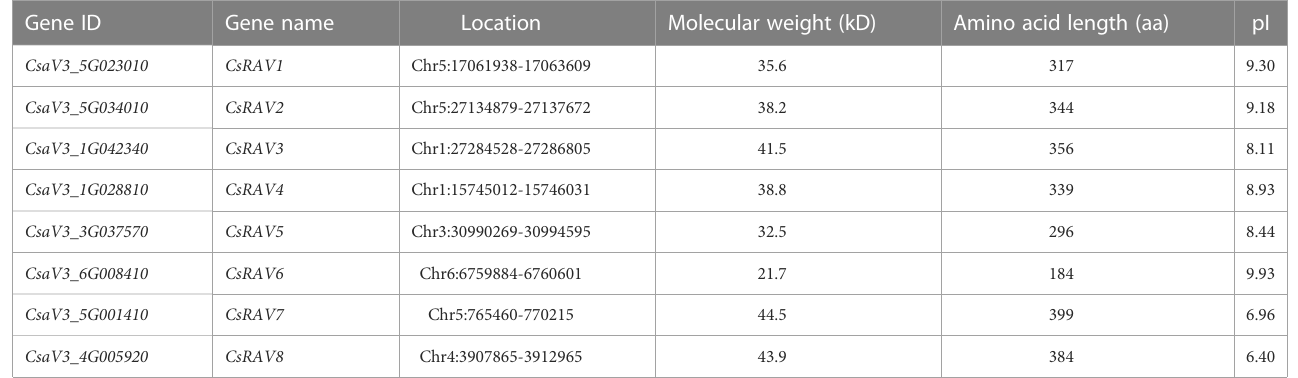
TABLE 1 Information of RAV genes in